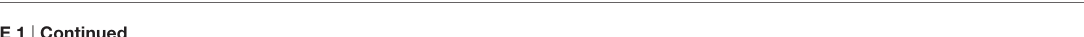
FiGURe 1 | Continued Core architecture, catalytic pocket occlusion, and computational/biochemical approaches to solving activation-induced cytidine deaminase (AiD)/APOBeC structures . (A) Representative ribbon structure (left) and surface topology (right) of AID modeled from APOBEC templates. In the ribbon structure, N- to C-termini progression is shown from blue to red and the gray sphere depicts active site zinc. In the surface topology, positive, negative,